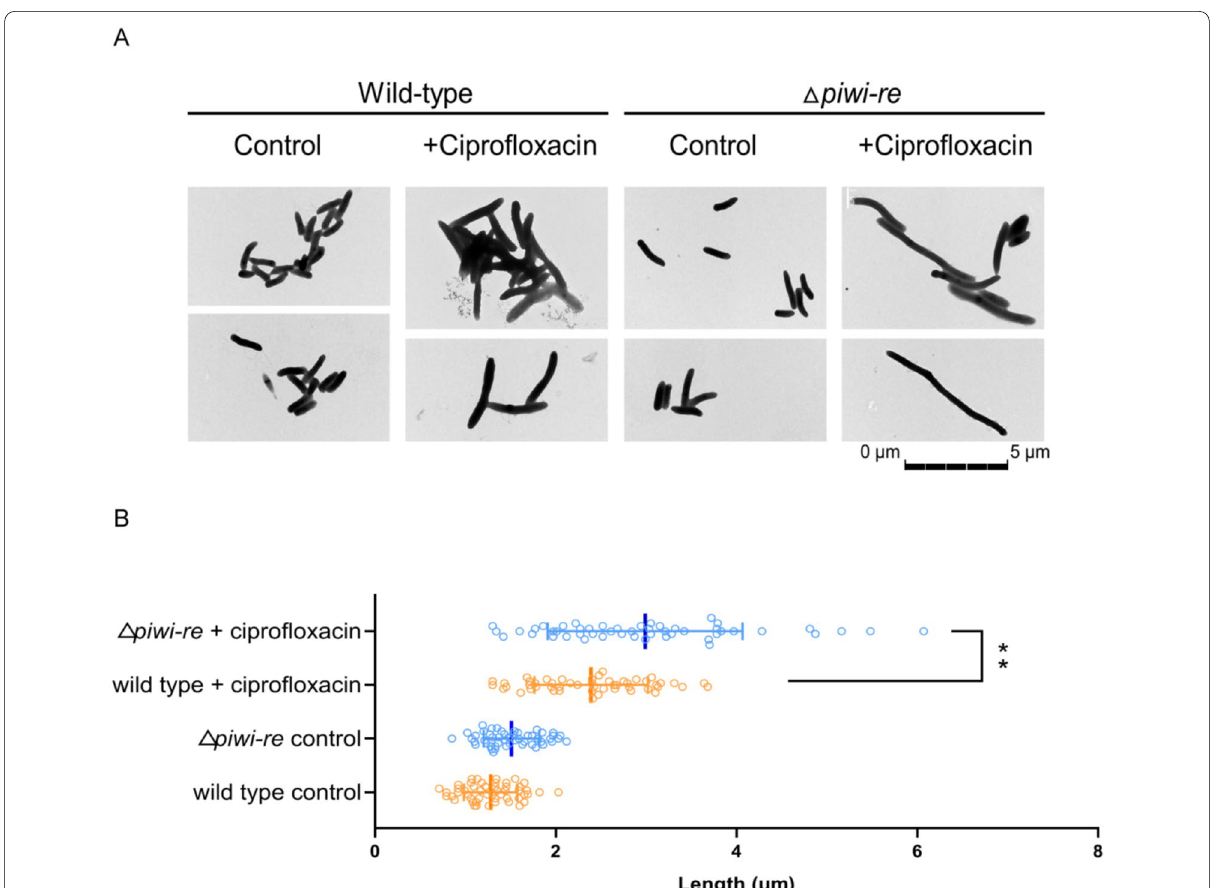
Fig. 5 Effects of ciprofloxacin on the morphology of wild-type and △ piwi-re strains of P. stutzeri . A The growth of wild-type P. stutzeri and △ piwi-re strains in the presence of ciprofloxacin. The wild-type and △ piwi-re strain cultures were grown to an optical density (OD 600 ) of 0.5 before being divided into two groups. One group was treated with 5 μM ciprofloxacin for 6 h, while the other group was not treated with ciprofloxacin and was the control. Experiments were performed in triplicate and representative transmission electron microscope images are shown. B Quantitative analysis of the effect of ciprofloxacin on strain length of wild-type and △ piwi-re strains of P. stutzeri . The lengths of 50 cells in each group were counted using Digital Micrograph software (Gatan, USA), The data were analyzed in GraphPad Prism 8. Mean values ** p 0.0010). The p value was calculated using an unpaired Student’s t =